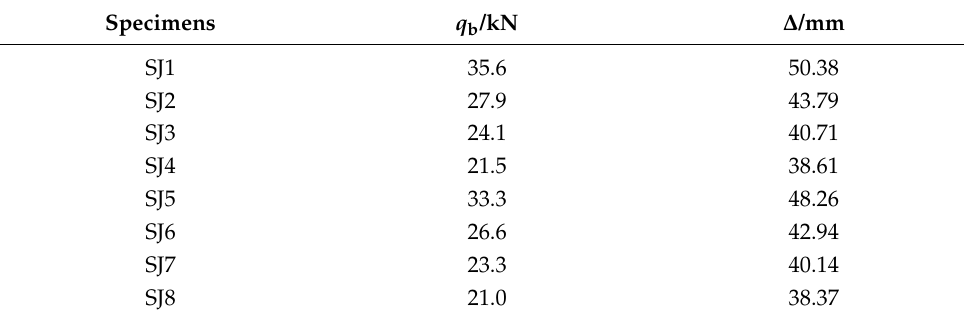
Table 5. The results of ultimate capacity and ultimate